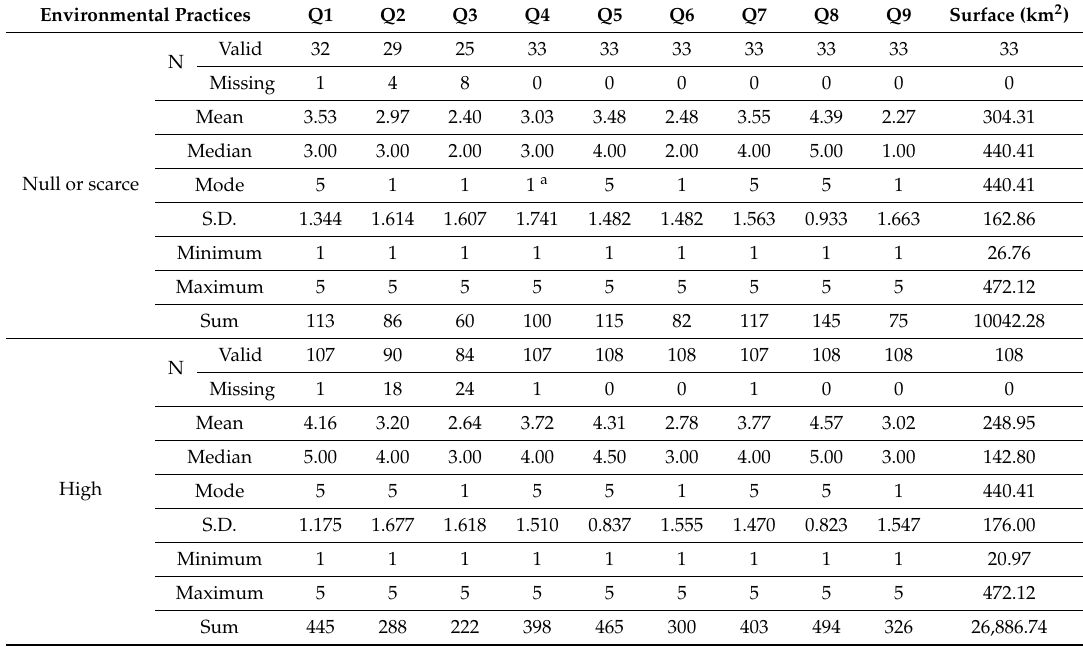
Table 2. Statistics of the